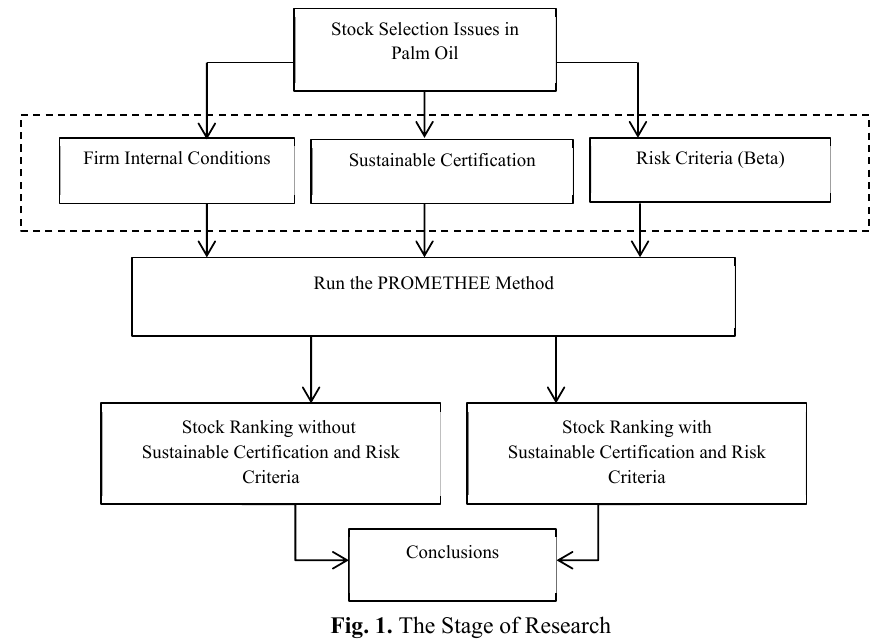
Fig. 1. The Stage of